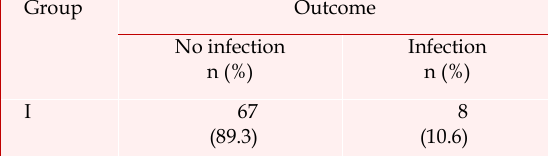
Proportion of subjects had wound infection in the study